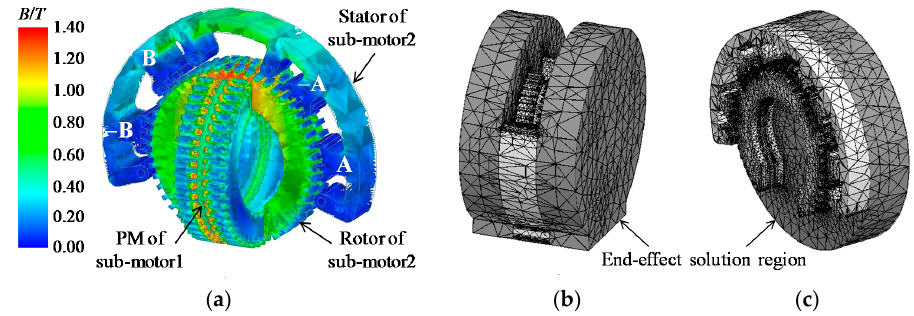
Figure 9. No-load calculation results obtained by 3-D FEA. ( a ) Magnetic field distribution produced by the PM of sum-motor1; ( b ) Mesh generation graph for sub-motor1; ( c ) Mesh generation graph for sub-motor2.